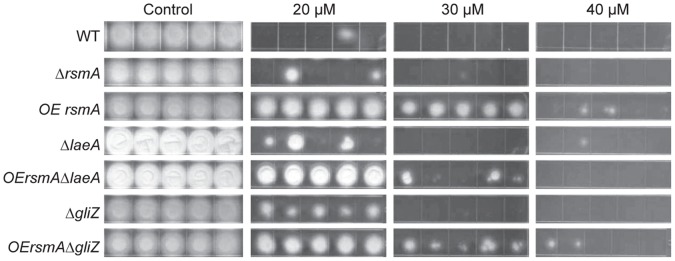

OErsmA mutants are resistant to menadione.For each strain, 105 conidia in 5 µl were spotted on GMM plates with 20 µM, 30 µM and 40 µM of menadione, or on GMM only for a control. Each strain was replicated 5 times. The plates were incubated at 37°C for 48 h.